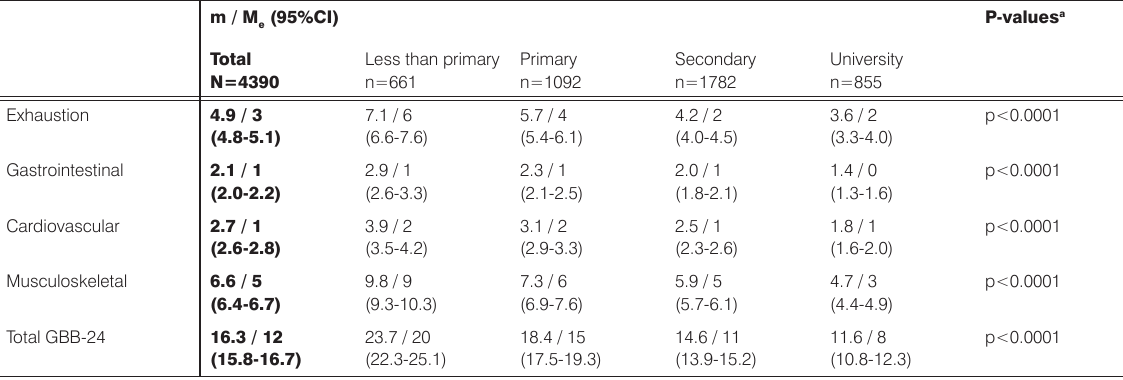
Table 1. Means, medians and means’ 95% confidence intervals of somatic symptoms (sub-scales and total) by education